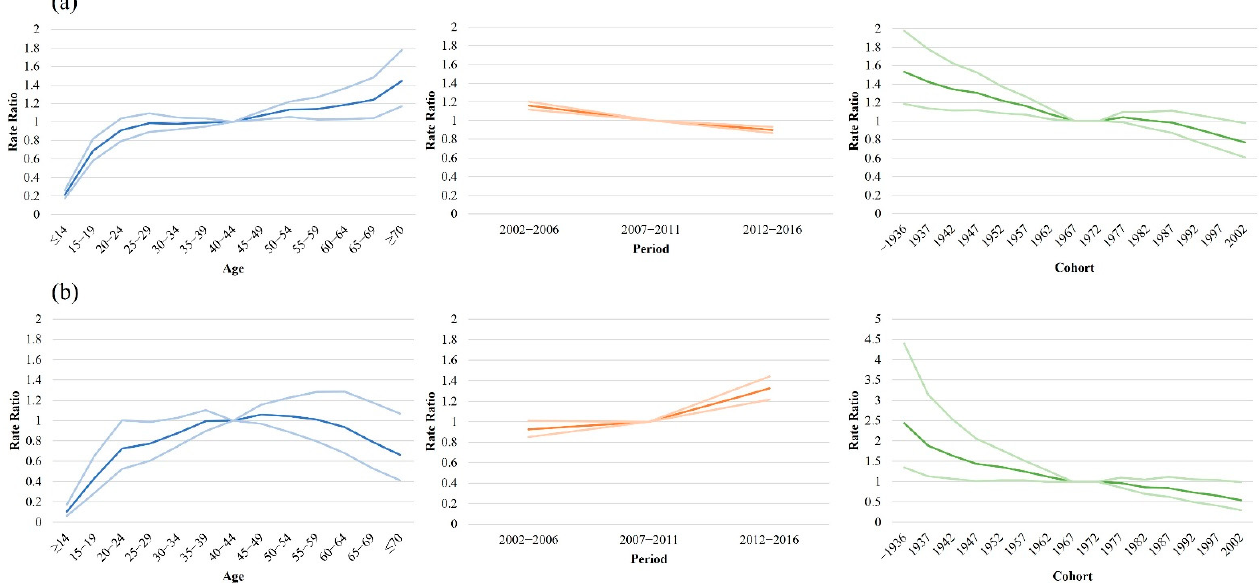
Figure 4. Three-factor age–period–cohort model analysis for incidence rate of ( a ) mild psoriasis and ( b ) severe psoriasis.